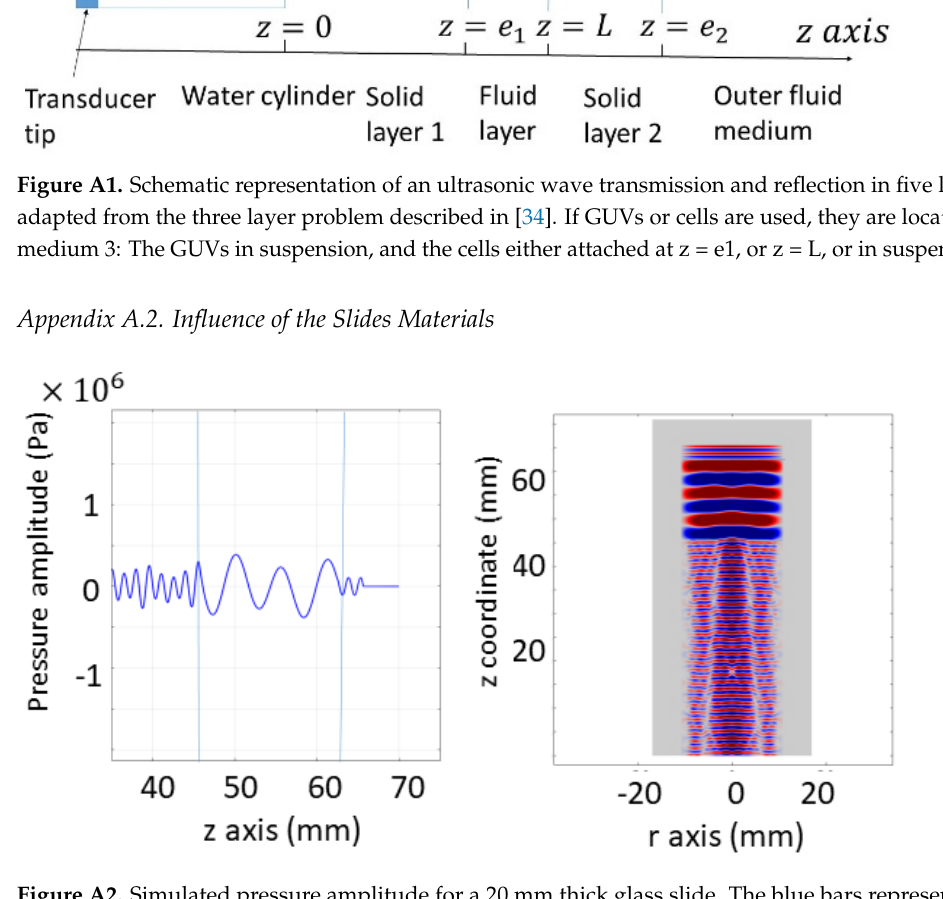
Figure A3. Absolute pressure amplitude along the z-axis depending on the distance between the slides (10 µm is the dark blue curve or 20 µm is the light blue curve). ( A ) Absolute pressure when the two slides are in polystyrene. ( B ) Absolute pressure when the two slides are in glass. Since graphs are displayed with an identical scale, glass transmits less power than polystyrene. Appendix A.3. Intromission Angle An interesting feature of interface arises when r 1 < r 2 and c 2 < c 1 or r 1 > r 2 and c 2 > c 1 . Under these conditions an “angle of intromission” exists and can be calculated using equation 7: